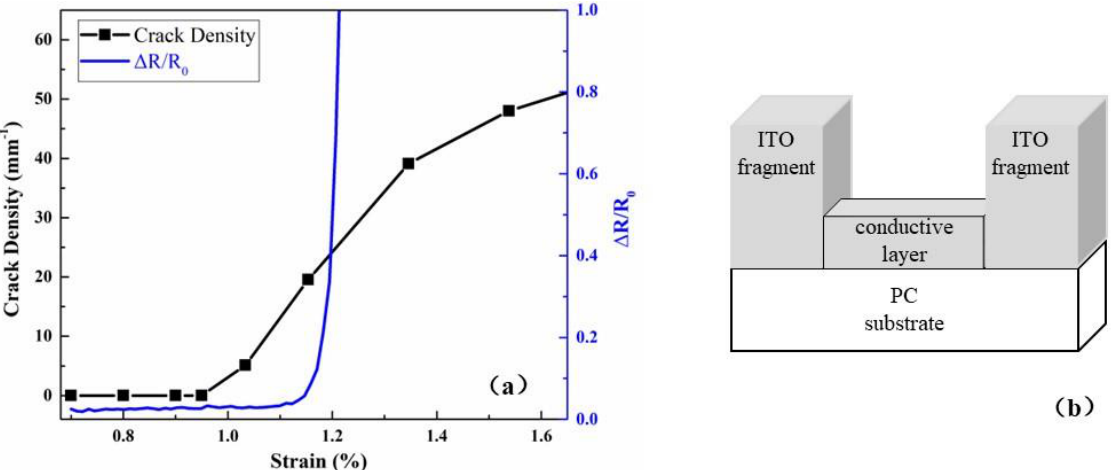
Figure 6. ITO films with different thicknesses on PC substrate: ( a ) CD; ( b ) CIS(t) and CD s (t).